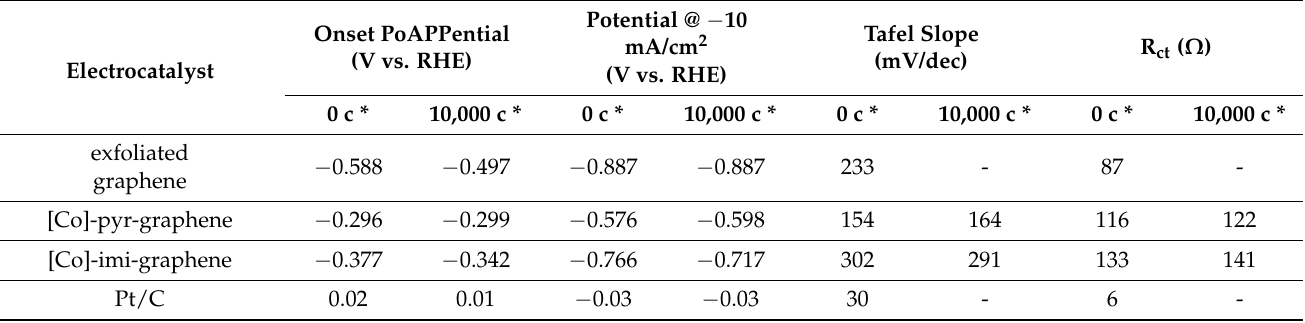
Table 2. Electrocatalytic HER parameters for exfoliated graphene, functionalized materials [Co]-pyr- graphene and [Co]-imi-graphene and benchmark HER electrocatalyst Pt/C. Potential @ − 10 Onset PoAPPential Tafel Slope mA/cm 2 R ct ( Ω ) (V vs. RHE) (mV/dec) Electrocatalyst (V vs. RHE) 0 c * 10,000 c * 0 c * 10,000 c * 0 c * 10,000 c * 0 c * 10,000 c * exfoliated − 0.588 − 0.497 − 0.887 − 0.887 233 - 87 - graphene 154 164 116 122 [Co]-imi-graphene − 0.717 302 291 133 141 Pt/C 0.02 0.01 − 0.03 − 0.03 30 - 6